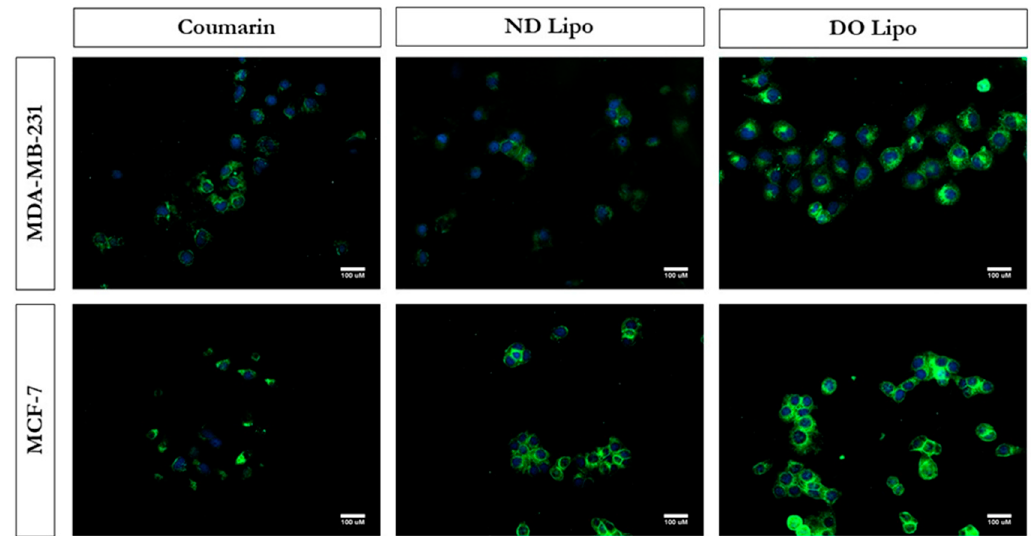
Figure 4. In vitro cellular uptake images of coumarin-loaded liposomes and coumarin solution (used as control) determined using florescence microscopy in MDA-MB-231 and MCF-7 breast cancer cells after 3 h of incubation. Representative images from n = 3 experiments. Scale bar = 100 μ m.